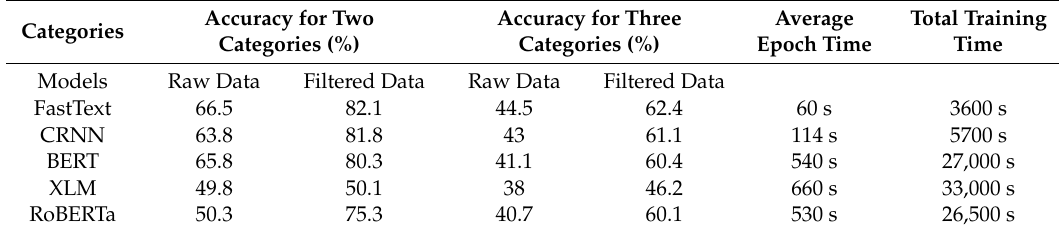
Table 2. Results of